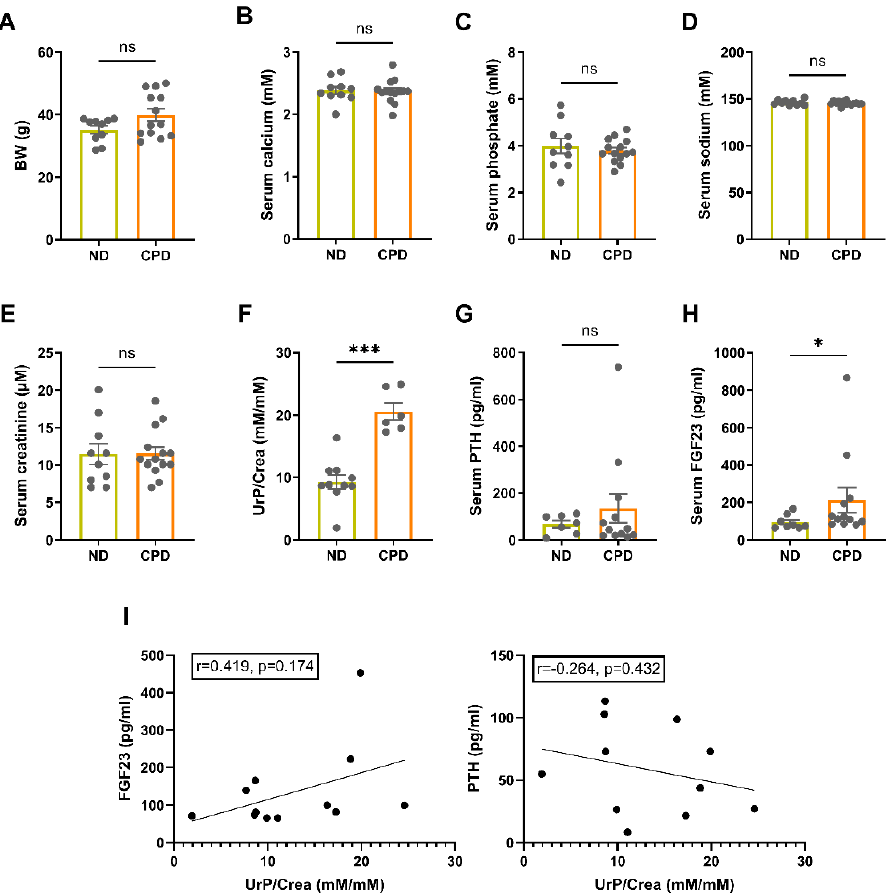
Figure 1. Mice maintained on CPD for 14 months have increased levels of FGF23, but normal kidney function. ( A ) Mice fed the CPD have comparable body weight (BW) to animals fed the ND ( n = 10 – 13). ( B – E ) CPD mice are normocalcemic, normophosphatemic, and normonatremic ( n = 10 – 14). (E) Serum creatinine levels are unchanged between CPD and ND mice ( n = 10 – 14). ( F ) Urinary phos- phate excretion relative to creatinine (UrP/Crea) is significantly increased in CPD mice compared to ND controls ( n = 6 – 10). ( G ) Serum PTH levels are not changed between ND and CPD mice ( n = 7 – 12). ( H ) CPD mice present with increased concentrations of circulating intact FGF23 ( n = 8 – 12). ( I ) Correlation analysis of serum FGF23 and PTH with urinary phosphate excretion ( n = 11 – 12). Bars in ( A – H ) represent mean ± SEM for ND and CPD mice. * p < 0.05, *** p < 0.001 by Mann – Whitney U- test. Insets show Pearson correlation coefficients. ns, not significant. 3.2. High Phosphate Intake in Aged Mice Leads to Hypertension, but Not Left Ventricular Hypertrophy Several earlier studies have reported LV hypertrophy in mice fed a high phosphate diet [27,28]. To assess cardiovascular function in our model of long-term dietary phos- phate excess, we phenotyped the mice via echocardiography, intraarterial and cardiac catheterization, heart histology, and expression analysis of cardiac hypertrophy markers. Heart weight-to-body weight ratio was not increased in mice on CPD, relative to ND con- trols (Figure 2A). Moreover, left ventricular function was unaltered between the groups, as evidenced by unchanged ejection fraction (EF), MaxdP/dt, end-diastolic pressure (EDP), and LV internal diameter (LVID) (Figure 2B-E). Furthermore, mice fed the CPD diet did not present with LV hypertrophy as evidenced by unchanged cardiomyocyte area meas- ured by wheat germ agglutinin (WGA) staining, unchanged LV collagen content meas- ured by picrosirius red staining, and similar cardiac mRNA expression of the molecular marker of hypertrophy, Bnp (Figure 2F-H). Notably, cardiovascular phenotyping revealed